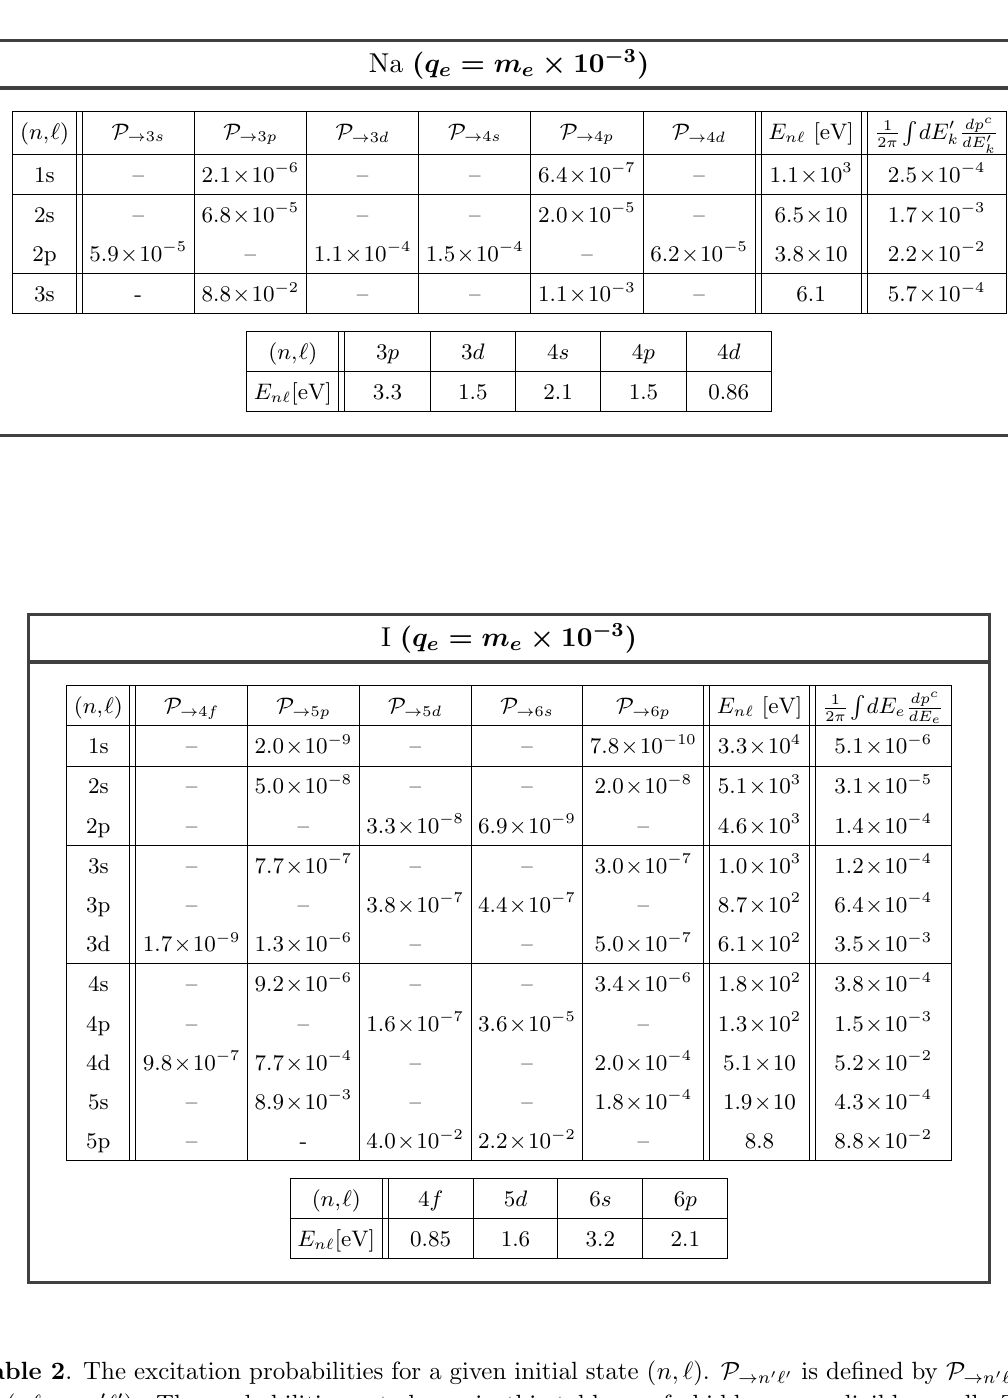
Table 2 . The excitation probabilities for a given initial state ( n; ‘ ). P ! n 0 ‘ 0 is de(cid:12)ned by P ! n 0 ‘ 0 (cid:17) p d ( n‘ ! n 0 ‘ 0 ). The probabilities not shown in this table are forbidden or negligibly small. The q e integrated ionization probabilities are also shown in the rightmost column. The averaged binding energies of the initial and the (cid:12)nal orbitals are also shown which are obtained by FAC .